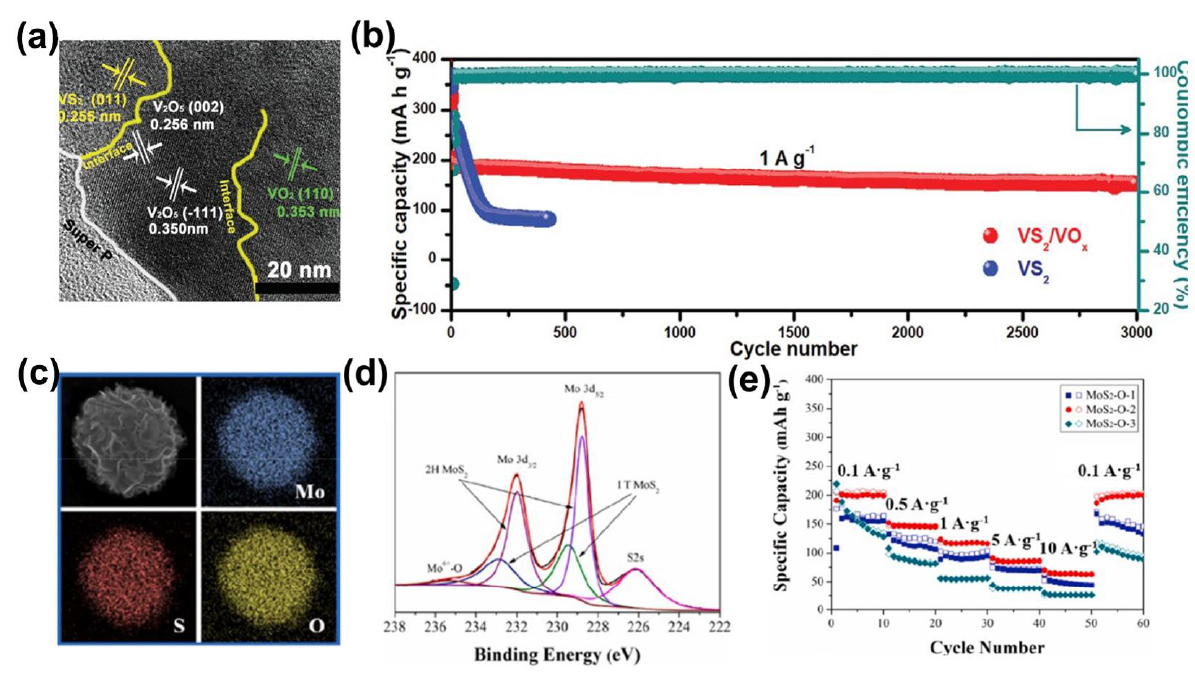
Figure 6. Modification of TMD − based ZIBs by electrochemical oxidation. ( a ) The TEM image of in situ formed VS 2 /VO x . ( b ) The cycling performance of VS 2 /VO x heterostructure at 1 A·g − 1 . Reprinted with permission from Ref. [47]. Copyright 2021, Wiley-VCH GmbH, Weinheim. ( c ) Elemental characterization in MoS 2 − O. ( d ) XPS survey spectra of MoS 2 − O. ( e ) Rate performance of MoS 2 − O at various current densities. Reprinted with permission from Ref. [17]. Copyright 2021, Elsevier.